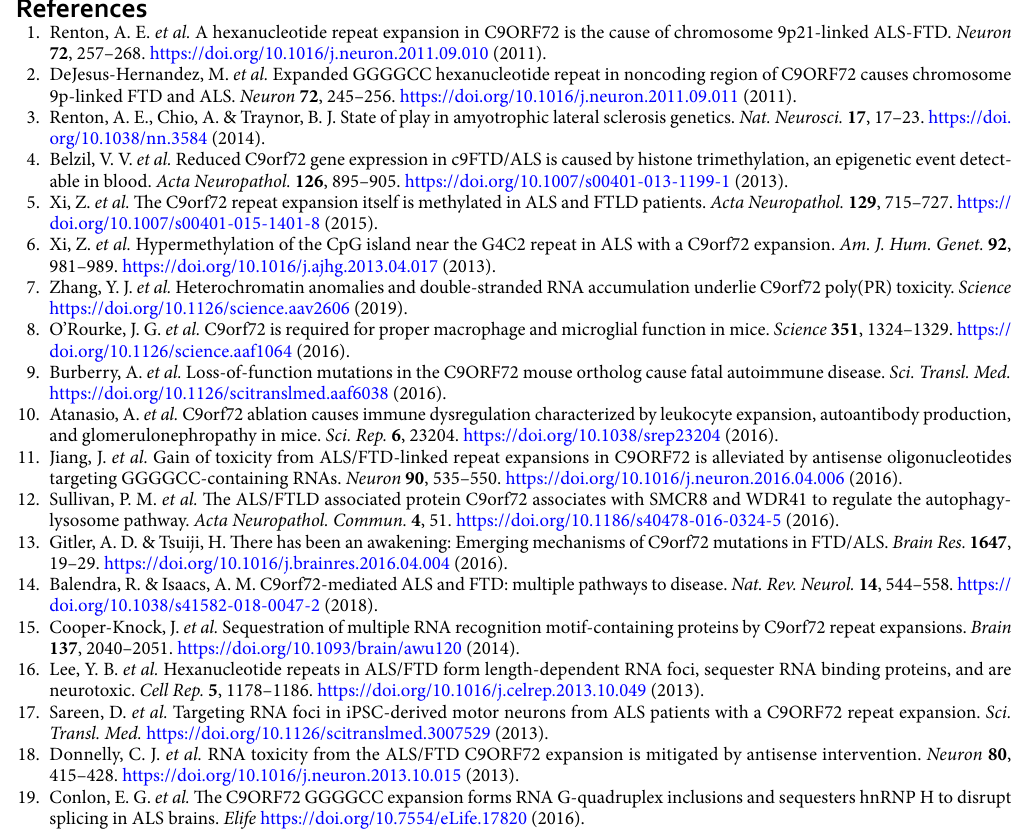
Figure 6. AAV-based dual gRNAs remove the C9ORF72 repeats and correct both sense and antisense RNA foci in vivo. ( A ) The experimental procedure for removal of the C9ORF72 repeats in vivo. The AAV-CamKII- EGFP or AAV-gRNA1-2-CamKII-EGFP (Supplementary Fig. 14) was injected into hippocampi of the Cas9/ + ; C9-Tg mice at one month of age and the infected hippocampi were harvested two months after injection. ( B ) The representative image of hippocampus infected with AAV-CamKII-EGFP. ( C and D ) The band (Δ) of fusion at two editing sites only appeared in the hippocampus (Hippo.) of the Cas9/ + ; C9-Tg mouse injected with AAV-gRNA1-2-CamKII-EGFP (gRNA1-2) but not in that with AAV-CamKII-EGFP (EGFP) or PCR negative control (H 2 O). The PCR conditions and primers as shown in Fig. 5A. The band (Δ) shown in ( C ) was applied for both forward and reverse Sanger sequencing ( D ). The editing site fusions were confirmed at the upstream of the PAM sites. ( E ) The AAV-CamKII-EGFP- or AAV-gRNA1-2-CamKII-EGFP-infected hippocampal CA1 regions of Cas9/ + ;C9-Tg mice were applied for the RNA foci measurement. The AAV-mediated EGFP expression was used to trace the infected region and neurons. The dotted line circled nuclei of CA1 neurons infected with indicated AAVs. ( F and G ) The percentage of infected neurons containing the RNA foci ( F ) and the number of foci per nucleus ( G ) were measured. For both sense and antisense RNA foci detection, animal numbers injected with AAV-CamKII-EGFP ( n = 7) or AAV-gRNA1-2-CamKII-EGFP ( n = 8). In F , the values are presented as mean ± SEM. In G , we employed “superplot” to show the spread in the number of foci per nucleus, and the values are presented as mean ± SD. ** p < 0.01, *** p < 0.001 (t-test, SPSS). Scale bar in b, 200 μm; in e,10